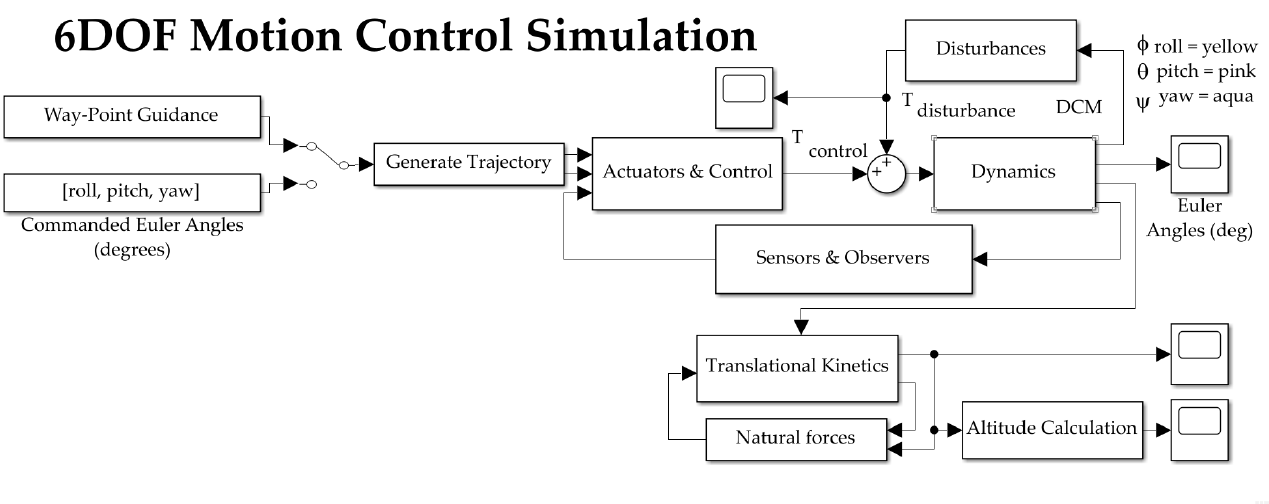
Figure A1. MatLab model with complete display of all Simulink subsystems.